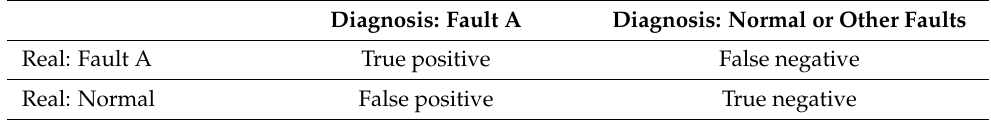
Table 5. The status table of real value and diagnosis. Diagnosis: Fault A Diagnosis: Normal or Other Faults